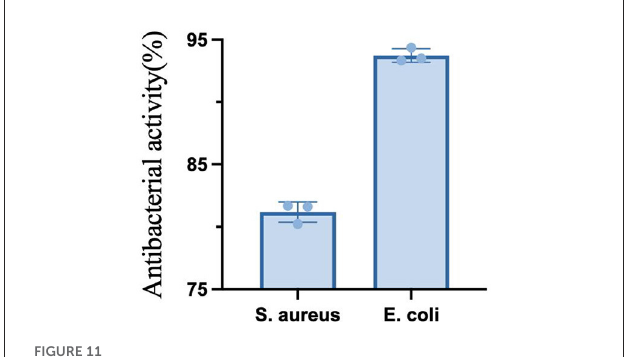
FIGURE11 Antimicrobial activity of quinoa